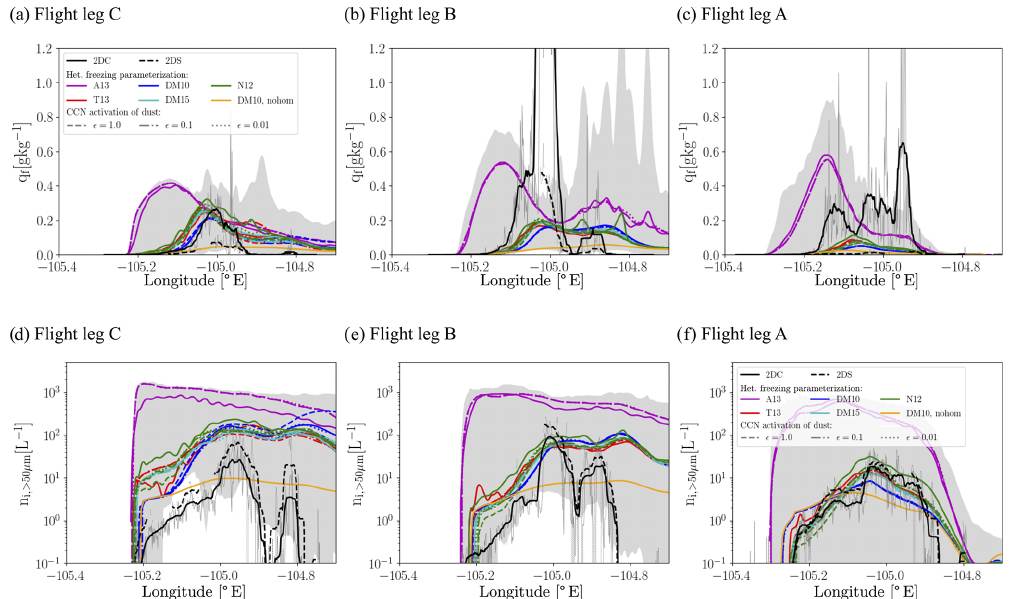
Figure 5. As Fig. 4 but showing the frozen hydrometeor (a–c) mass mixing ratio and (d–f) ice crystal number concentration. The data (mass mixing ratios as well as number concentrations) incorporate only crystals larger than